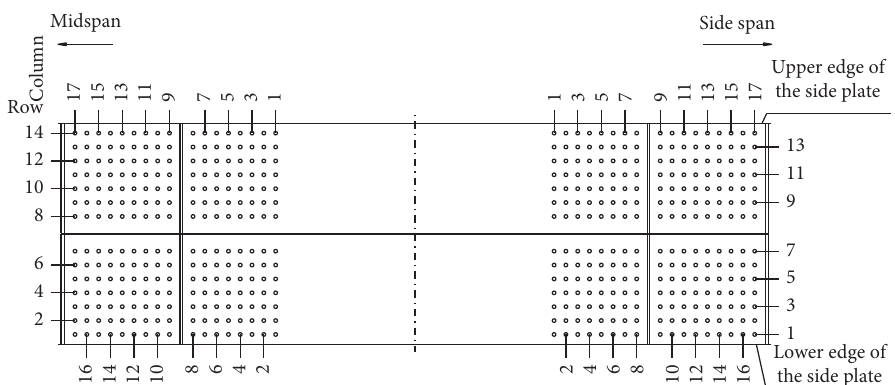
Figure 17: Stud group numbers.